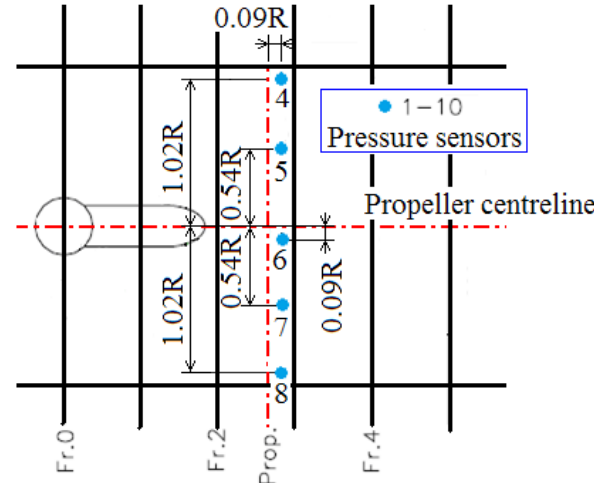
Figure 5: Pressure sensors configuration during sea trials.